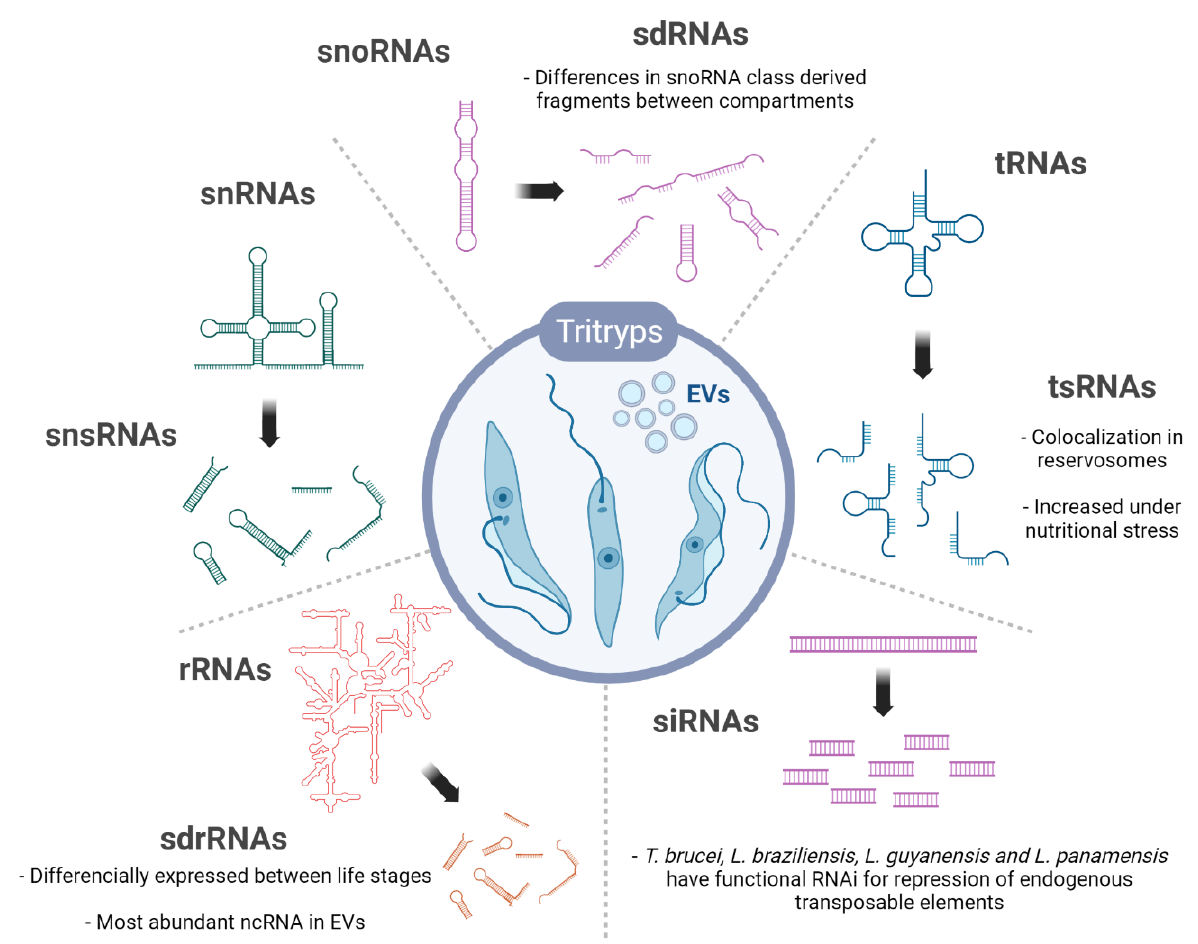
Figure 2. Overview of the ncRNAs and their derived sncRNAs products identified in trypanoso- matids. The sncRNAs represented were found in at least one trypanosomatids, either intracellular and/or in EVs (Extracellular vesicles). snsRNA, sdRNA, tsRNA, sdrRNA are the small RNAs de- rived from snRNA, snoRNA, tRNA and rRNA, respectively. Specific features or observations are commented on with the text. Created with BioRender.com (accessed on 13 May 2022).